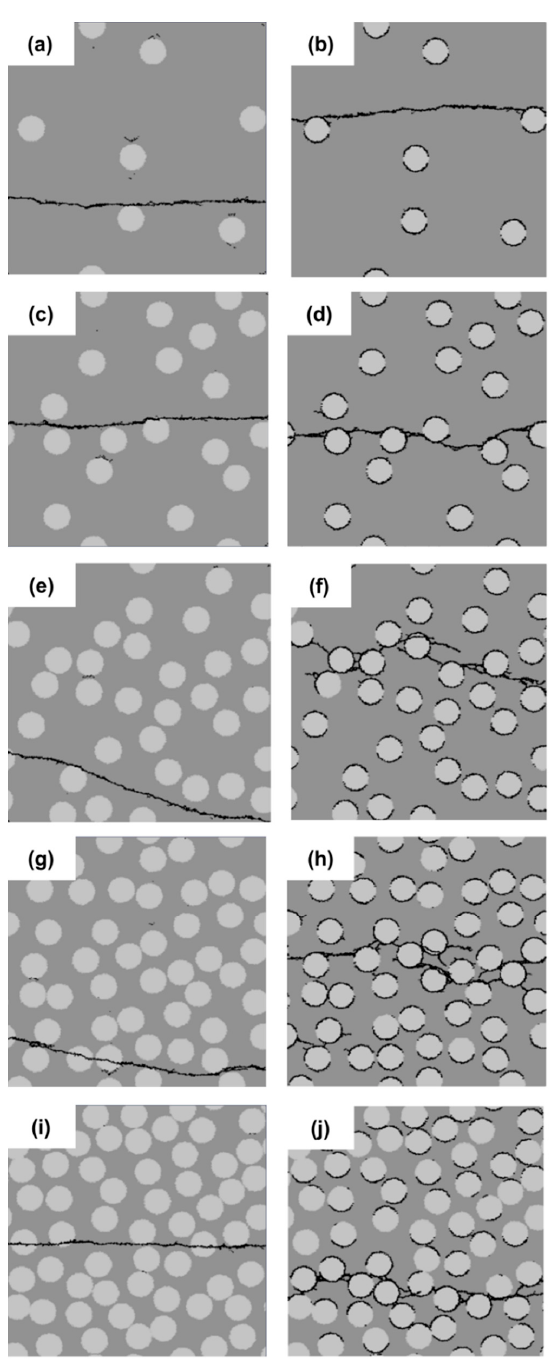
Figure 13. Micro-crack patterns of specimens with randomly-distributed filler particles and five different filler area fractions (5% ( a , b ); 15% ( c , d ); 25% ( e , f ); 35% ( g , h ) and 45% ( i , j )).